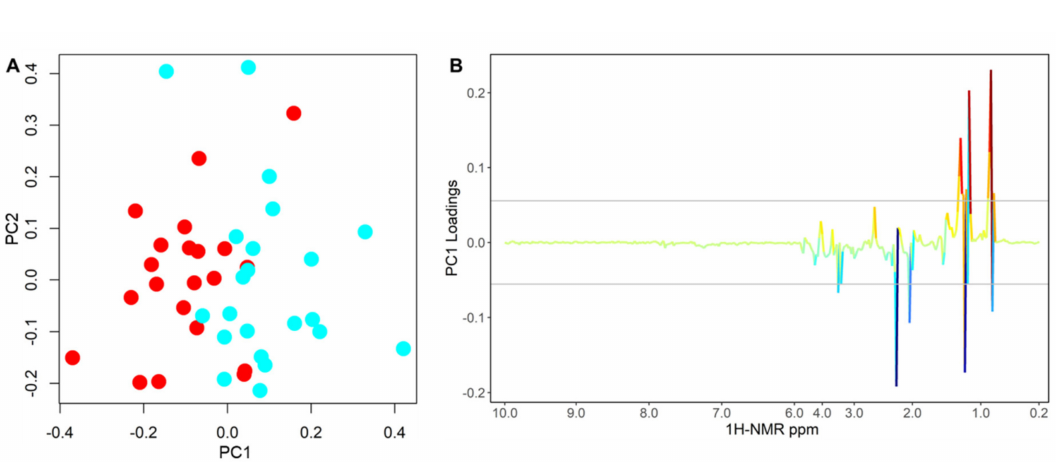
Figure 1. PCA-CA of 1 H NMR CPMG spectra of baseline plasma samples from HER2-positive ER( + ) (cyan) and ER( − ) (red) breast cancer patients. Score plot of the first two PCA-CA components ( A ) and loading plot of PC1 ( B ). Model LOOCV accuracy of 74.4%, p -value =